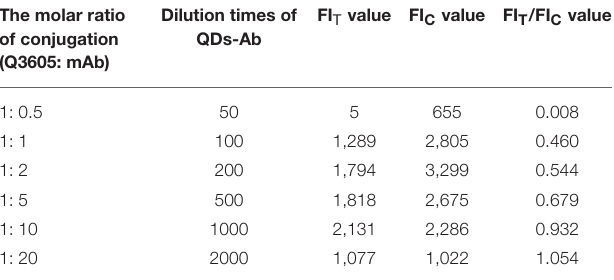
TABLE 1 | Optimization of the molar ratio of Q3605-mAb